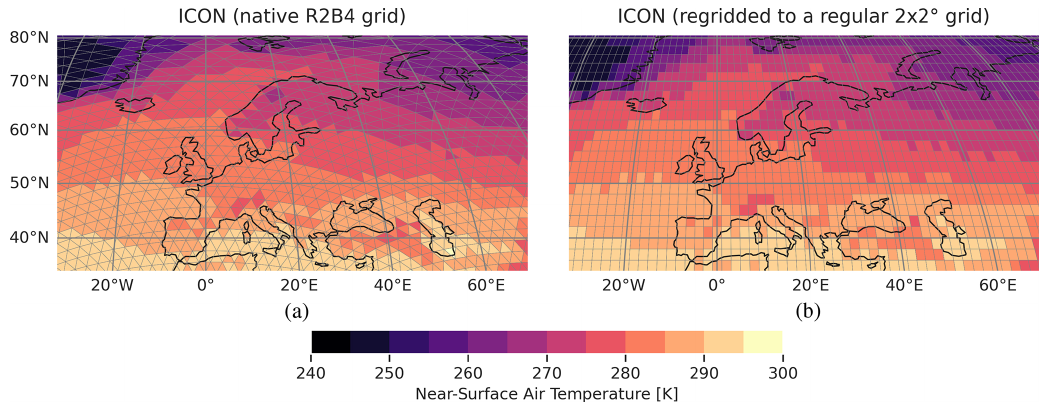
Figure 2. Illustration of the regridding of an unstructured grid using the near-surface air temperature climatology over Europe averaged from 1979 to 2014 as an example. The ICON simulation shown here corresponds to the one described in Fig. 3. (a) Native ICON grid at R2B4 resolution (about 160km). (b) Regular 2 ◦ × 2 ◦ grid that results from ESMValTool’s nearest-neighbor regridding of the data shown in (a)